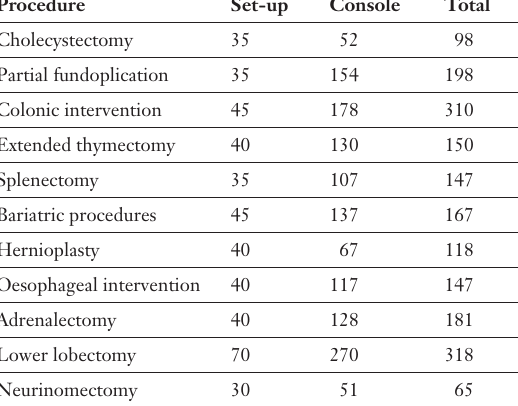
Times for each procedure (median in